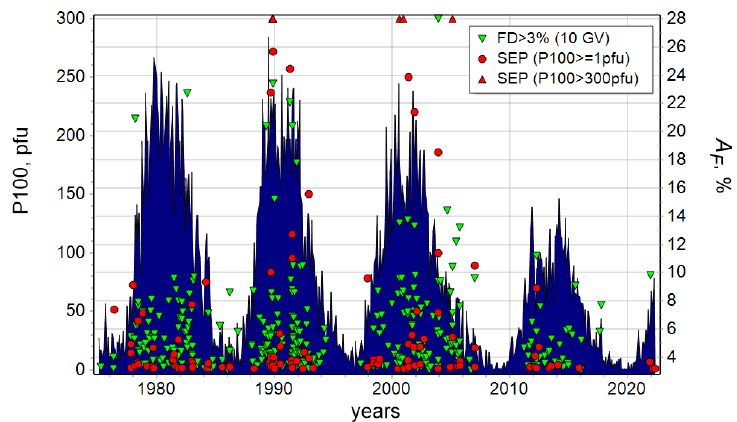
Figure 1. Distribution in time and magnitude of large FDs ( A F > 3%) and SEPs with a maximum flux of > 1 and > 300 pfu for particles with energies E > 100 MeV against the background of the sunspot